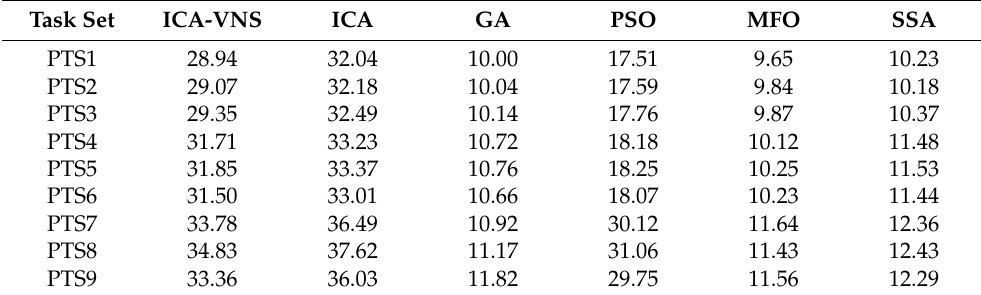
Table 10. The AV (CPU) value comparison of six